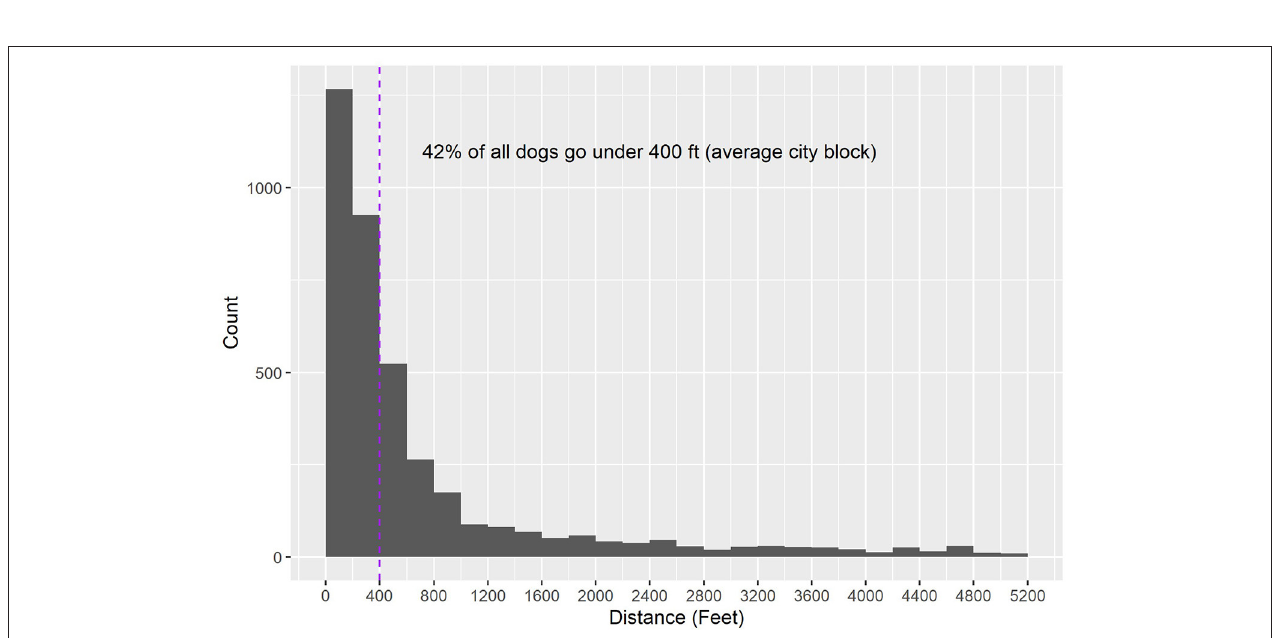
FIGURE 4 | Distance traveled by RTO strays, excluding those with identical intake and outcome addresses, zoomed in on dogs who traveled up to 1mile. The 400 ft mark is indicated with a purple line.